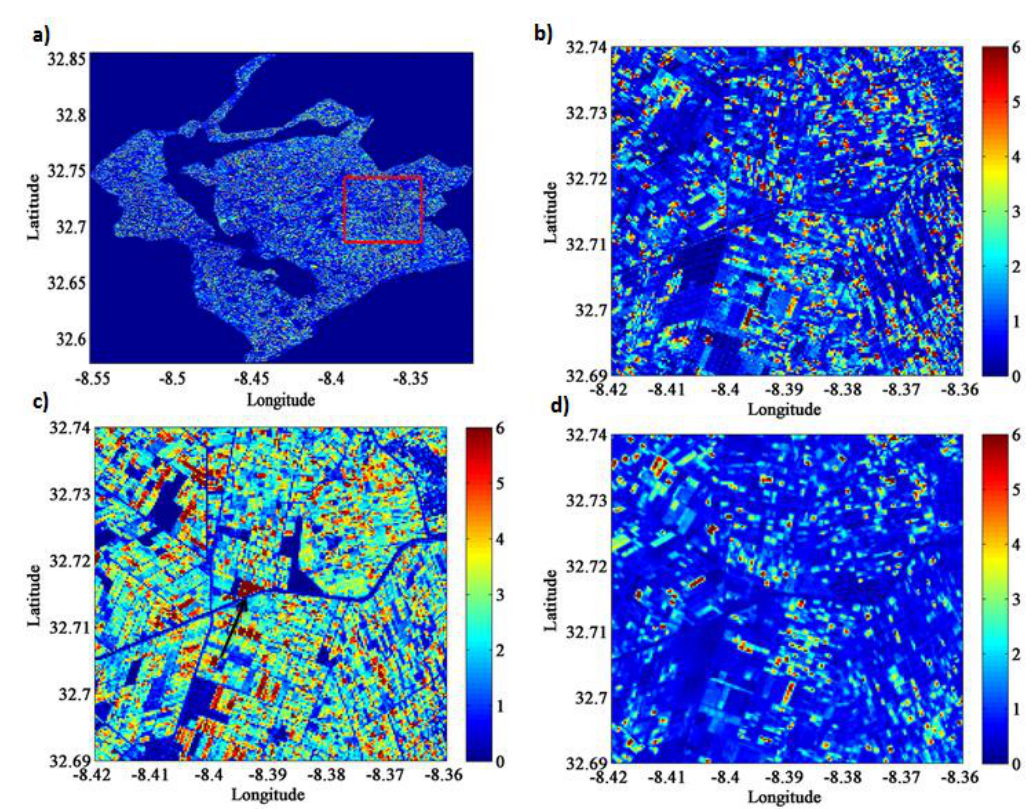
Figure 7. Spatial and temporal variability of LAI in Sidi Bennour ( a ) (LAI inset in December ( b ); February ( c ) and July ( d